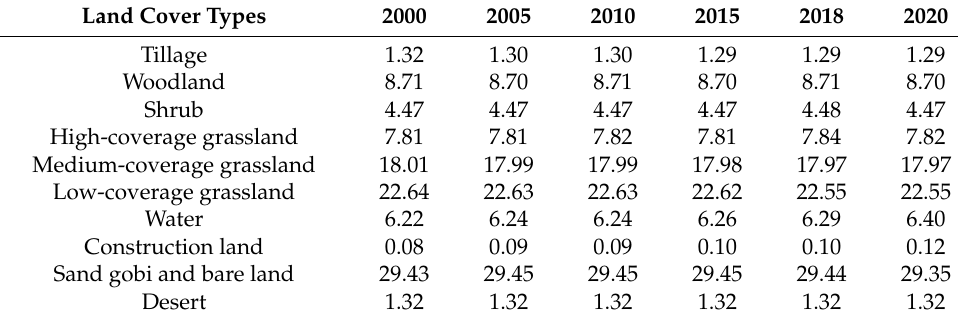
Table 2. The land covers area ratio (%) of the TP from 2000 to 2020.